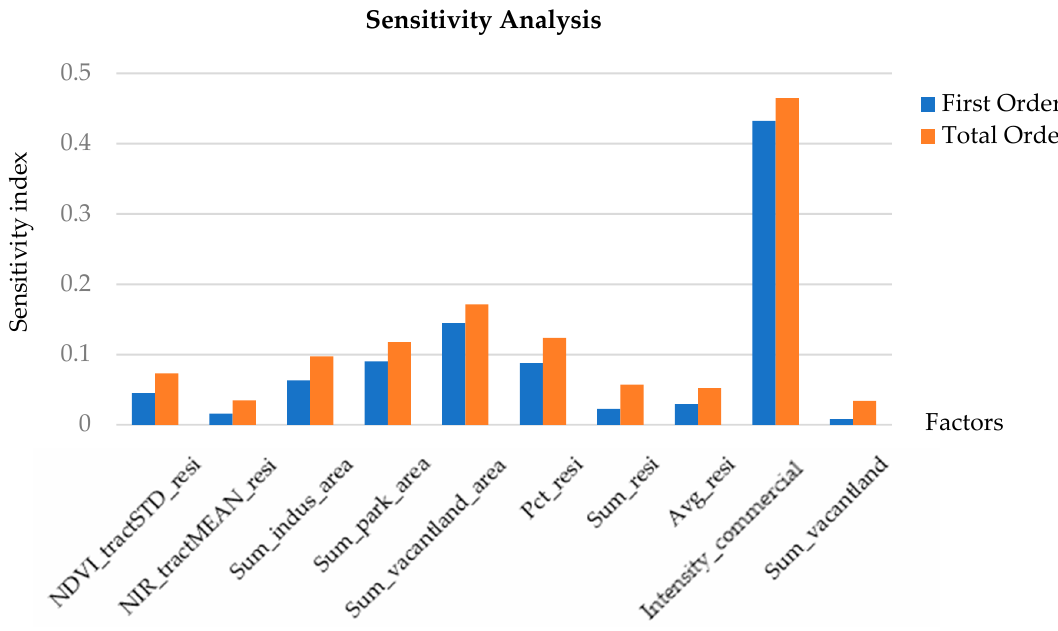
Figure 7. Sensitivity analysis of Stepwise Multivariate Linear Regression Model 2 (with Jilin1-03 satellite NTL data).